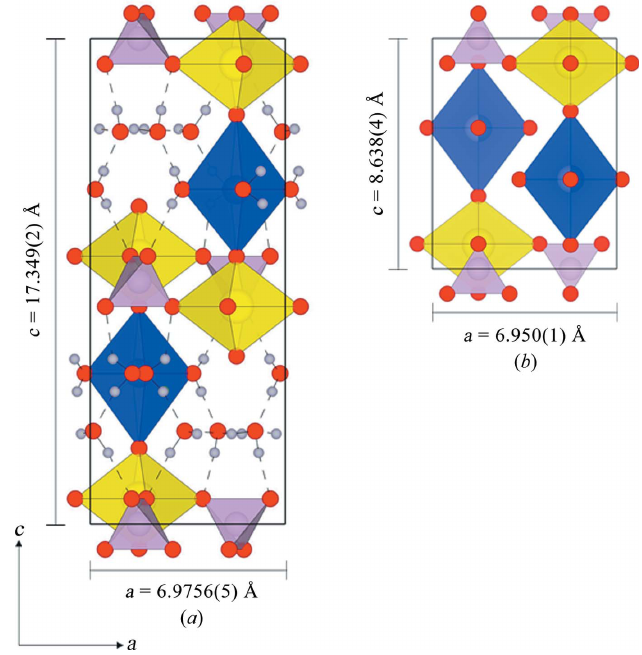
Figure 1 ( a ) An ac projection of the structural model of metatorbernite published by Locock & Burns (2003). ( b ) An ac projection of the structural model of metatorbernite published by Calos & Kennard (1996). Uranyl polyhedra are shown in yellow, phosphate tetrahedra in lilac and copper octahedra in blue; oxygen atoms are displayed as red spheres and hydrogen as light grey spheres. Hydrogen bonds are displayed as dashed